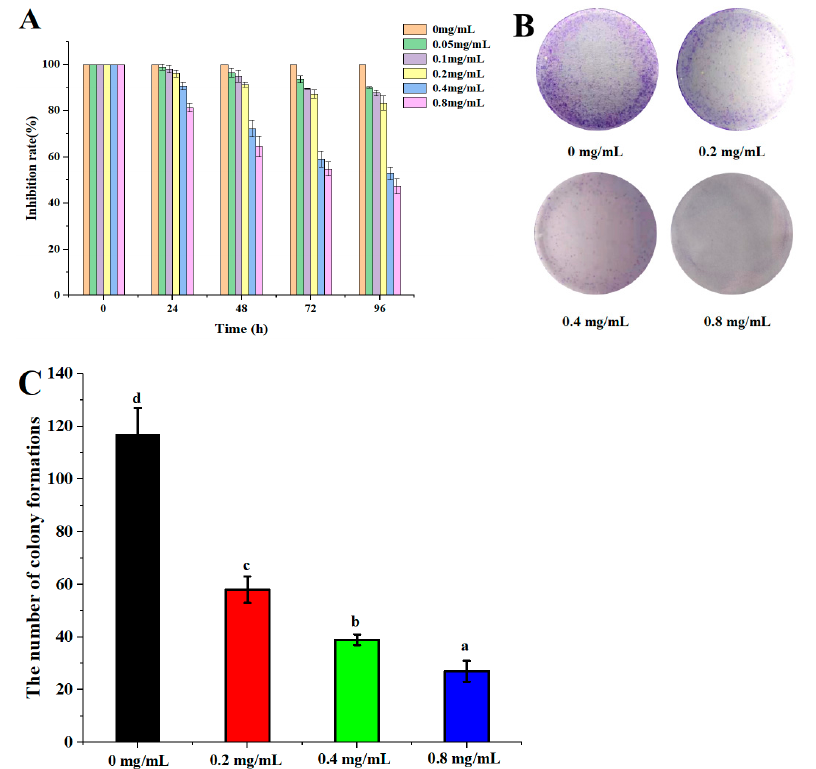
Figure 6. DLP-3 inhibits HepG2 cells proliferation in vitro. HepG2 cells were treated with different concentrations (0, 0.2, 0.4, and 0.8 mg/L) of DLP-3 for 0, 24, 48, 72, and 96 h: ( A ) The effect of DLP-3 on cell proliferation was evaluated using an MTT assay; ( B , C ) the clonogenicity of the indicated cells were detected after treatment with different concentrations of DLP-3. Data are presented as the mean ± SD, n = 3. Different letters above the bars indicate significant difference.